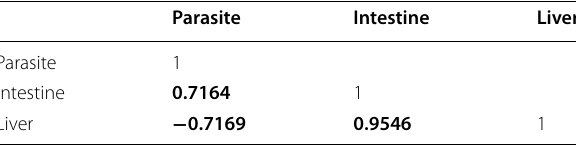
Table 2 Correlation of zinc concentrations in the nematode parasite Cosmocerca sp. and the tissues of the host Sclerophrys regularis in Lagos metropolis,